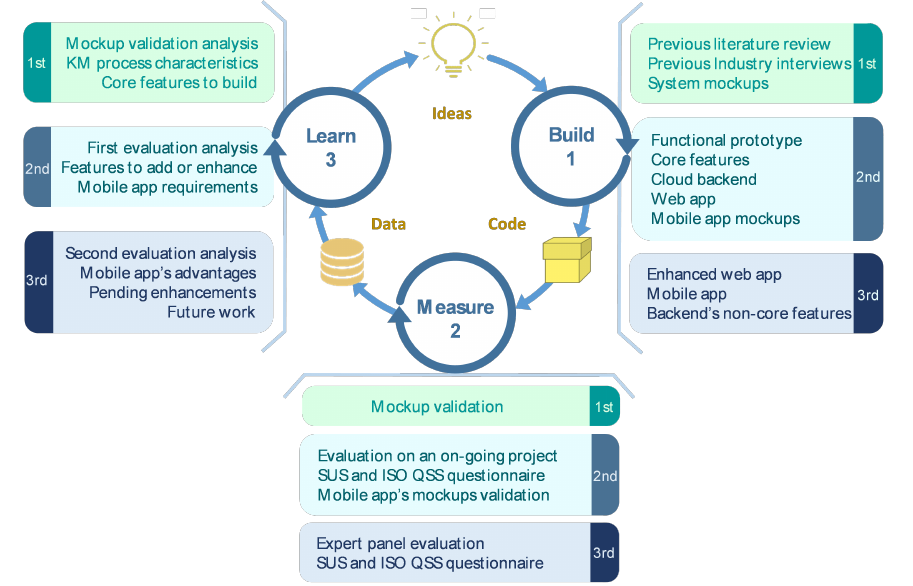
Figure 1. The Build-Measure-Learn feedback loop and the main activities performed on the first, second, and third